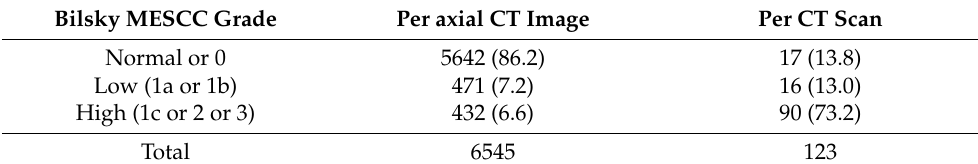
Table 4. Reference standard gradings for metastatic epidural spinal cord compression.